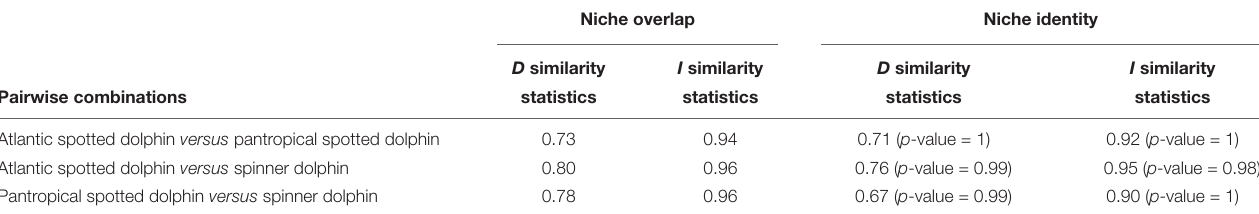
FIGURE 5 | Predicted potential distribution for the spinner dolphin in the Caribbean Basin from the best ecological niche model. Red colors indicate highest habitat suitability and blue lowest suitability. TABLE 3 | Metrics obtained in niche overlap comparison and niche identity tests conducted pairwise between Stenella species. Niche overlap Niche